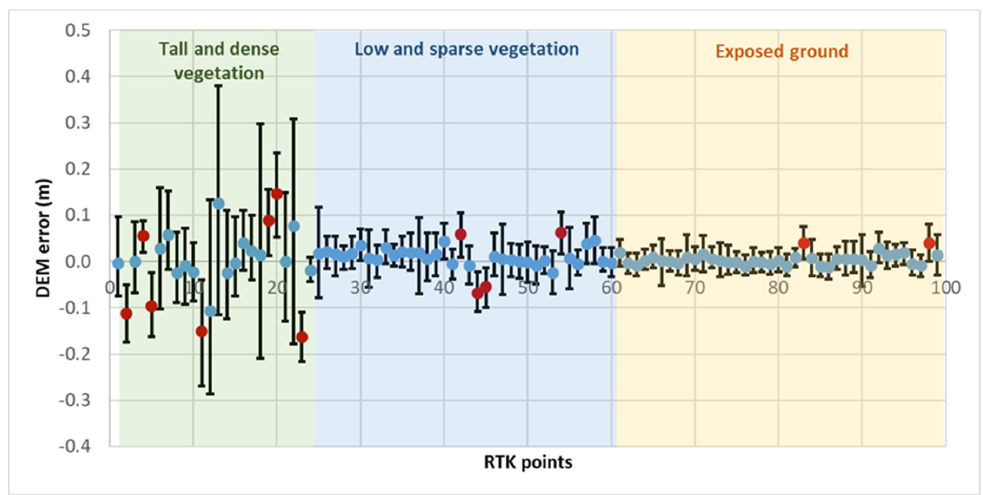
Figure 12. Corrected DEM error and estimated 95% tolerance intervals / uncertainty ranges of the error corrections for the 12-input ENN compared with the 100 independent RTK points. Referring to the dots, positive values indicate that the corrected DEM elevations are higher than the RTK ground truths. Zero values indicate that the corrections are equal to the RTK values. Negative values indicate that the corrections are lower than the RTK points. The bar represents the tolerance interval for each correction. Red dot indicates that the tolerance interval did not include the RTK elevation. Grey dot indicates that the tolerance interval did include the RTK elevation.